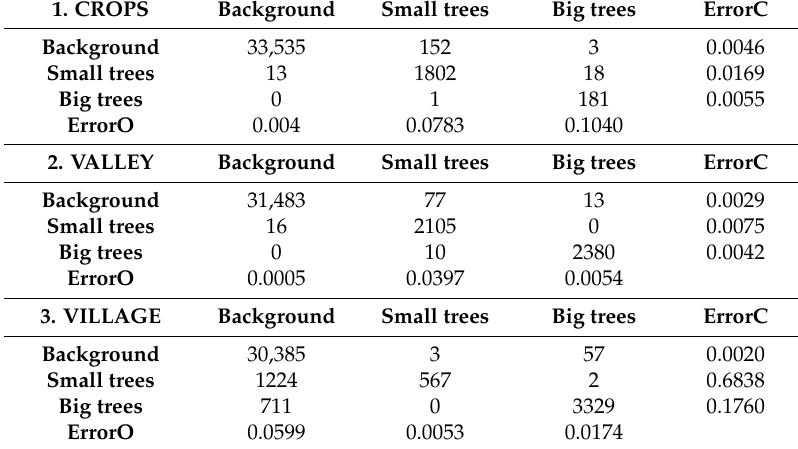
Table 1. Error matrix analysis for three sites (on a pixel basis). Ground truth in columns, classification in rows. Guileyni.